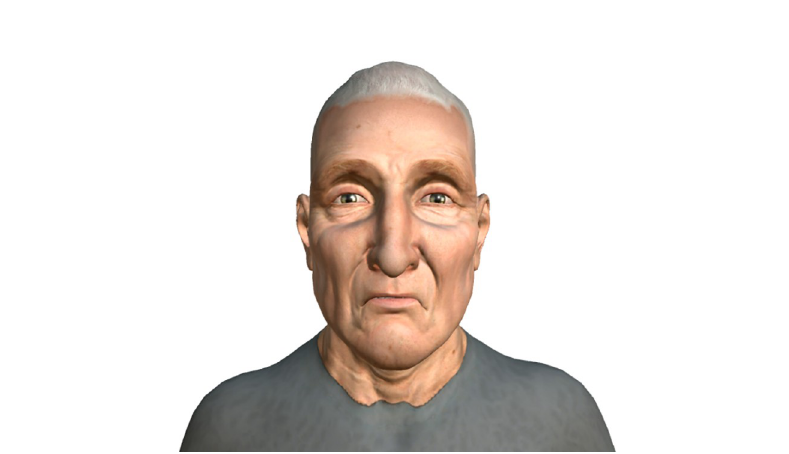
Fig 2. Reproduction of the Miserable sadness expression on a